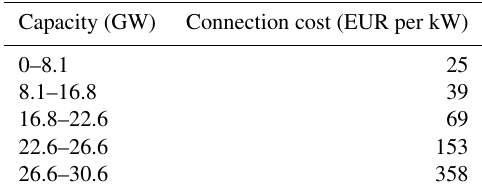
Table 3. Onshore wind connection cost.